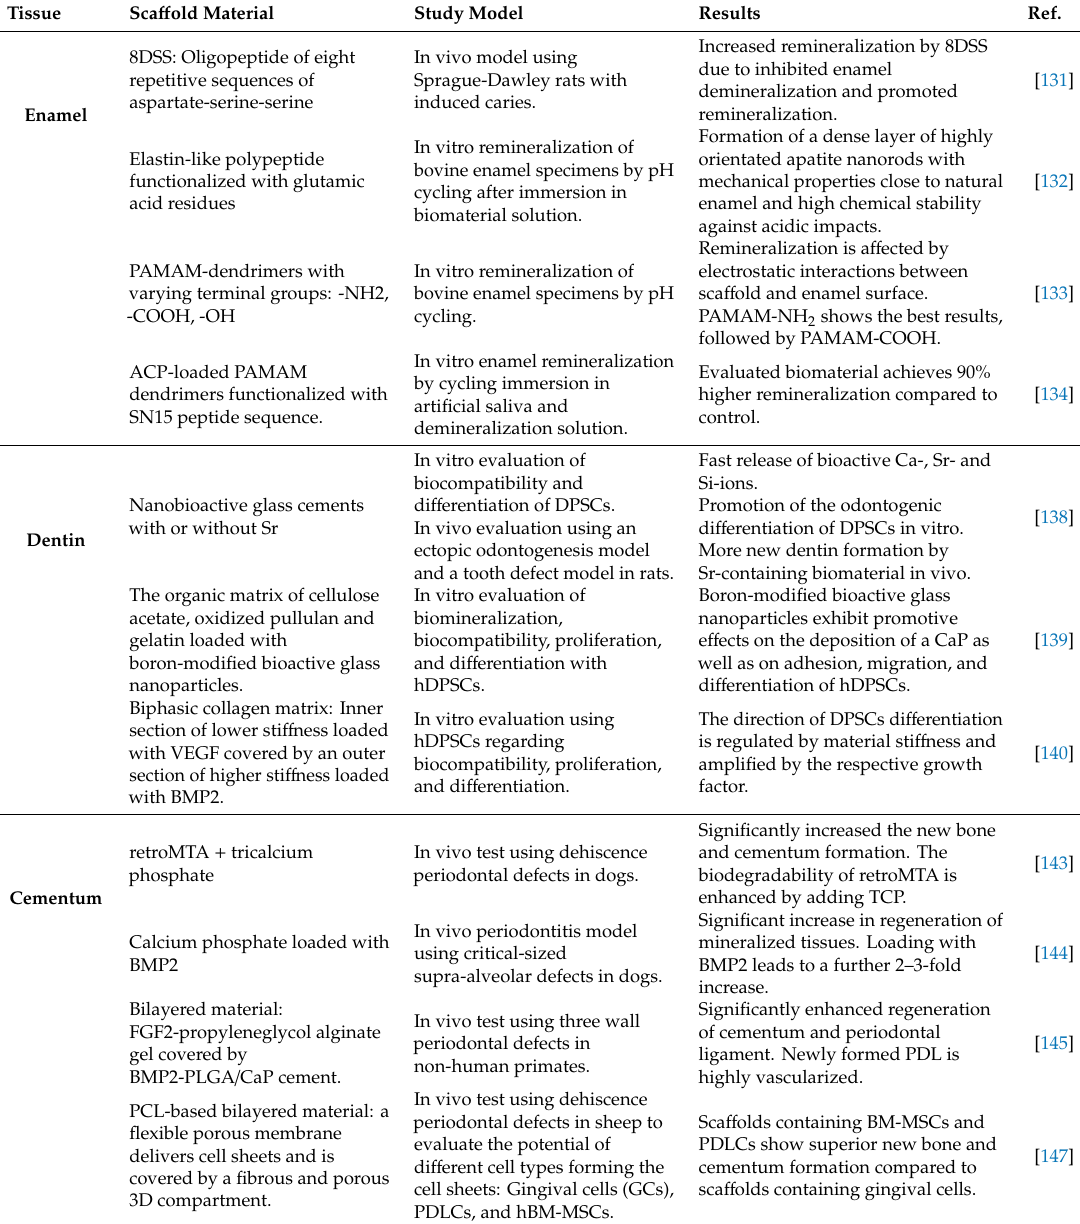
Table 2. Compilation of recently published studies emphasizing regenerative approaches of enamel, dentin, and